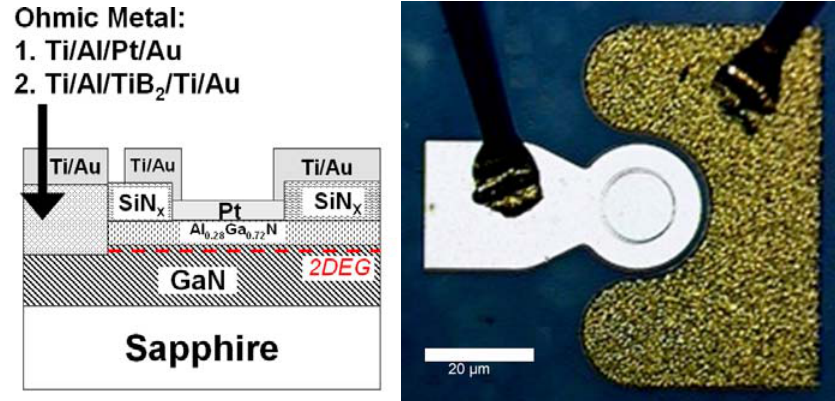
Figure 8. Cross-sectional schematic of completed MOS diode on AlGaN/GaN HEMT layer structure (left) and plan-view photograph of device(right).